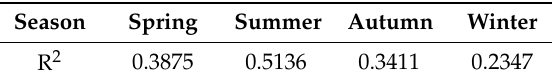
Table 7. R 2 for different